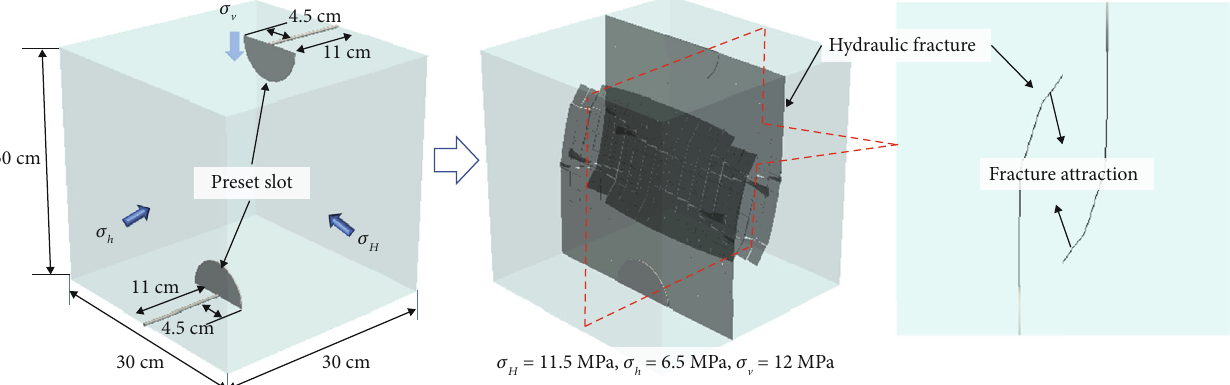
Figure 8: Spatial pattern of two oppositely propagating hydraulic